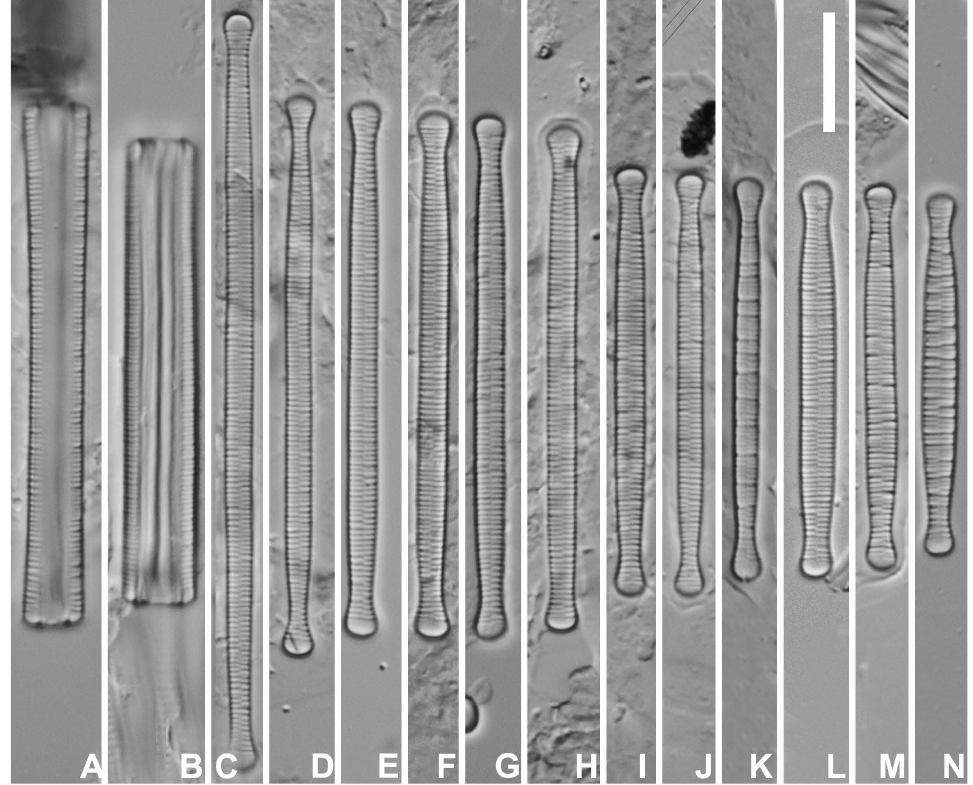
Figure 1 – Distrionella coxiana , LM of the type population from Rancho Hambre, Tierra del Fuego (sample RH2016-CP4-PER2): A & B, LM views of two entire frustules in girdle view; C–N, LM views of several valves in valve face view showing the observed size range. Scale bar = 10